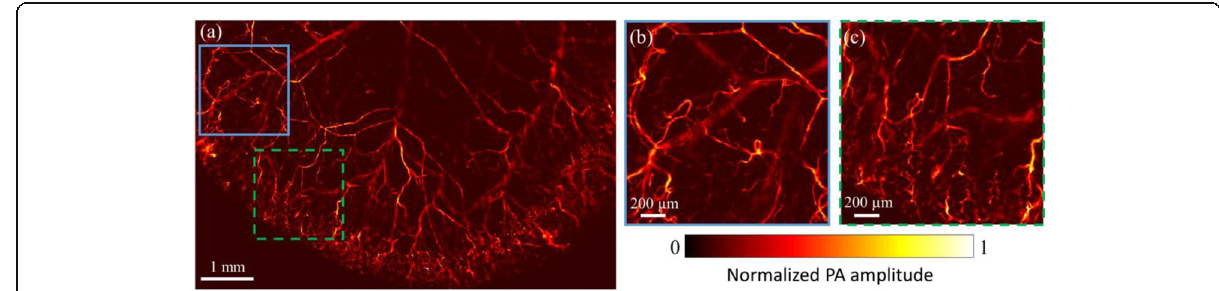
Fig. 4 a In vivo LD-based PAM imaging of a mouse ear. b and c Close-up images of the blue and green marked regions in Fig.